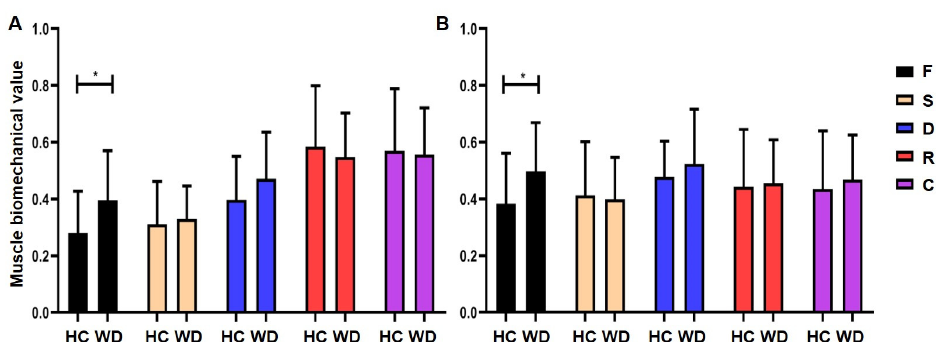
Figure 2. Group differences in muscle biomechanical level. ( A ) Differences between WD and HC on the right gastocnemius medialis muscle biomechanical levels. ( B ) Differences between WD and HC on the right gastrocnemius lateralis muscle biomechanical levels. Abbreviations: F, frequency of muscle oscillation; S, muscle stiffness; D, rate of decrement; R, muscle pressure release time; C, Deborah number; HC, healthy control; WD, Wilson’s disease; * p < 0.05.